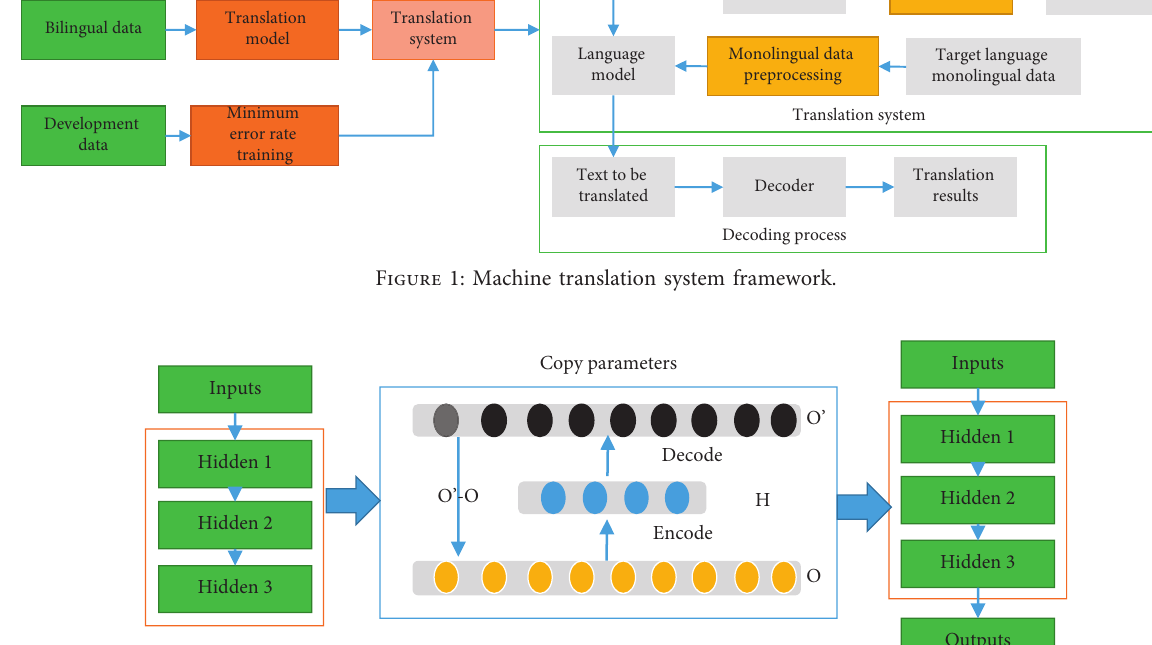
Figure 2: Unsupervised training based on automatic